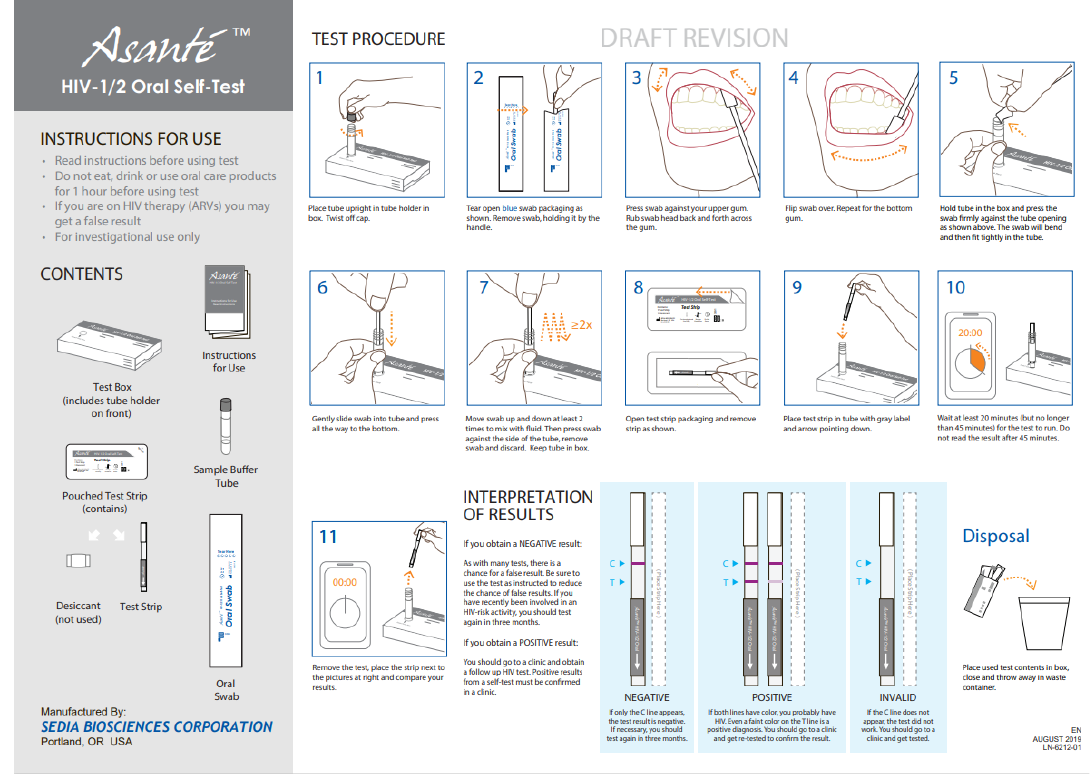
Figure A1. Asante™ HIV-1/2 Oral self-test used in South Africa.